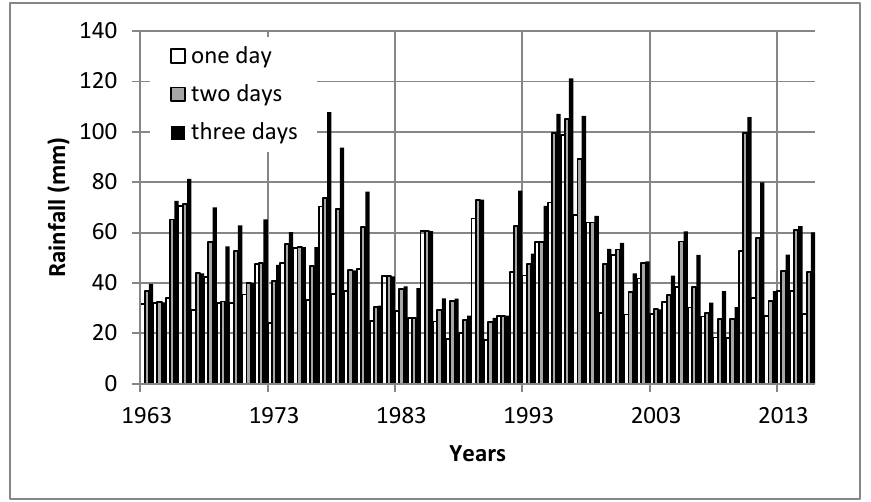
Figure 5. Maximum one-, two-, and three-days ’ rainfall in the watershed of Zagożdżonka river in the period 1963–2015; no trend in data series detected.